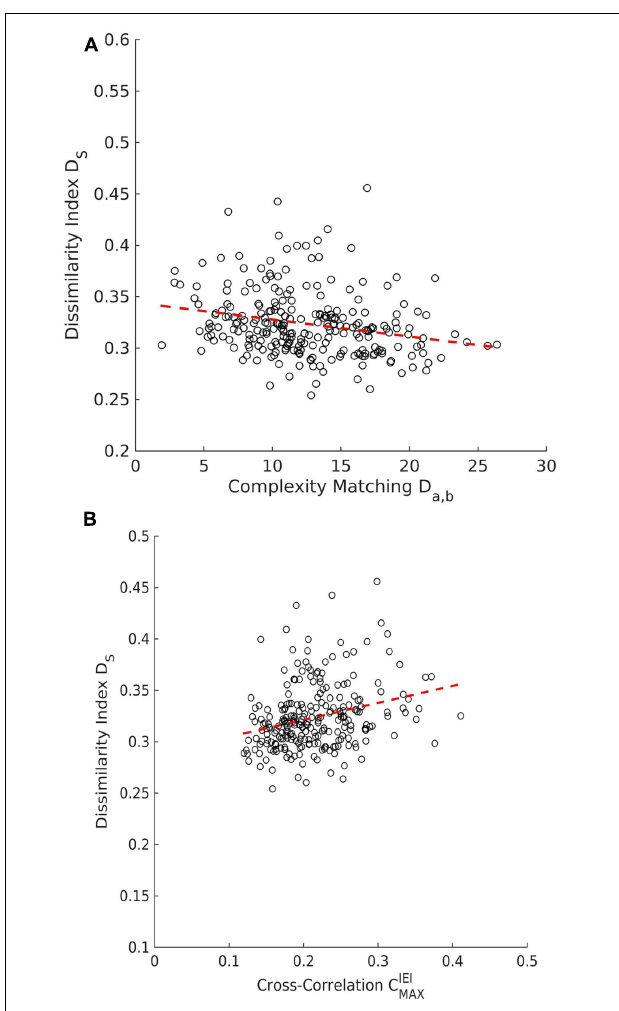
FIGURE 8 | Scatter plots for SPIKE-distance. (A) There is a negative correlation between the dissimilarity index D s and complexity matching ( D a , b ) . (B) The dissimilarity index D s and the maximum peak of the cross-correlation of IEI ( C IEI ) show that are positively correlated positive MAX